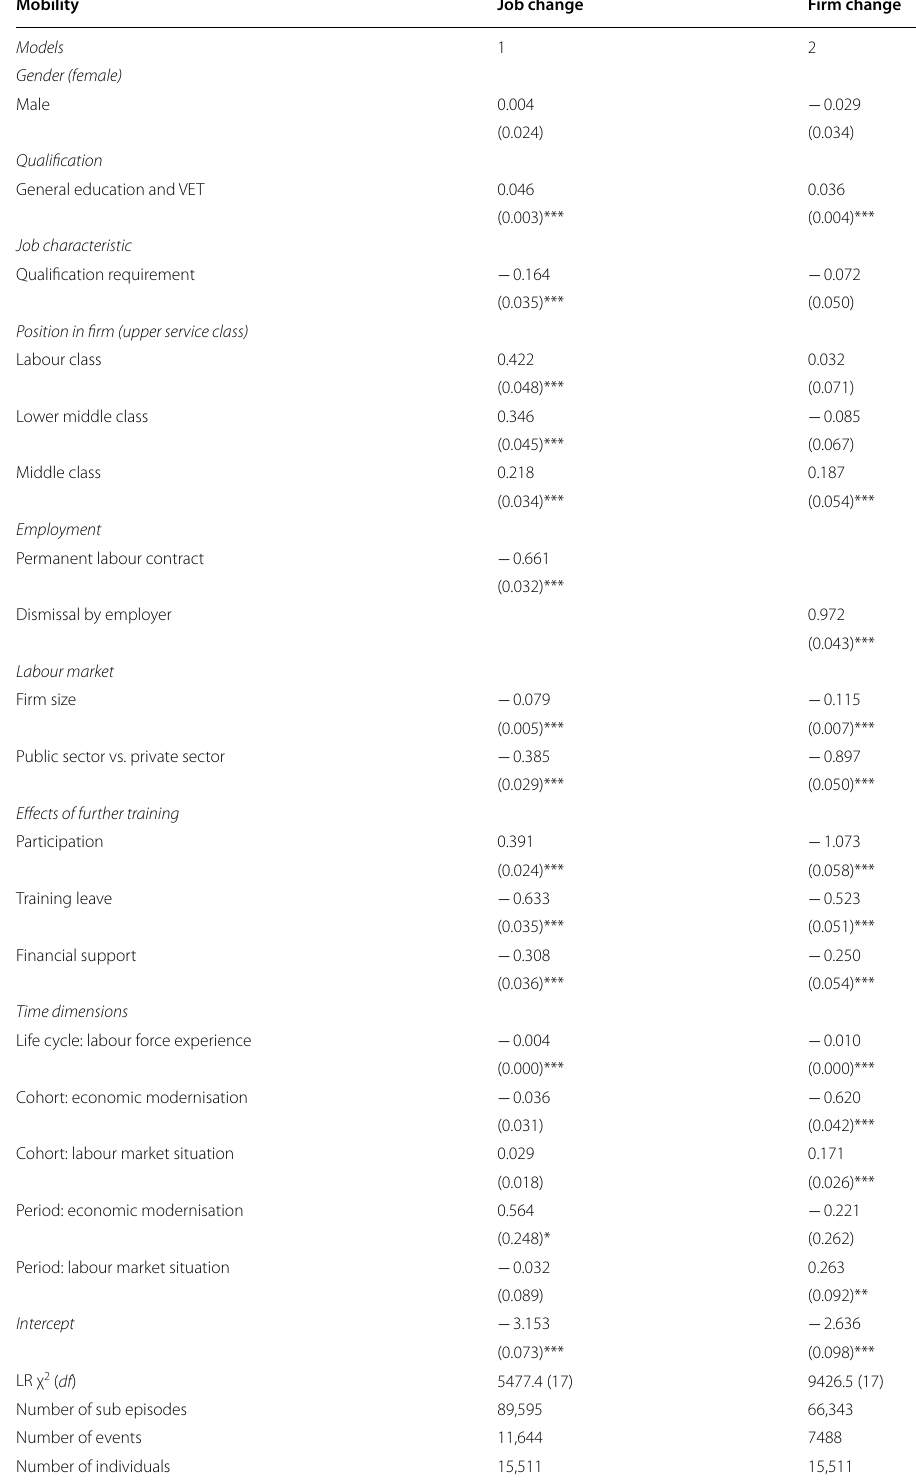
Table 4 Effects of further training on mobility processes—change of job and company (exponential